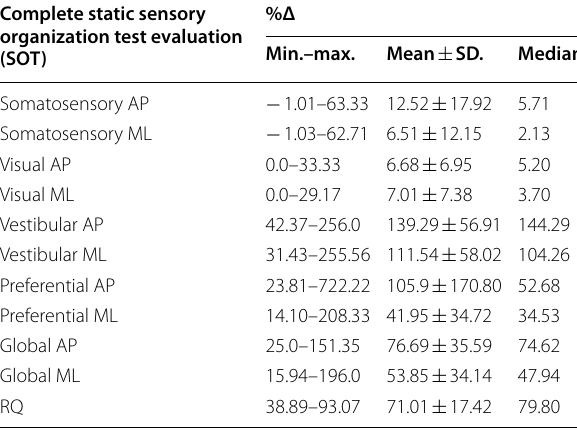
Table 6 Descriptive analysis of the % change (%Δ) in